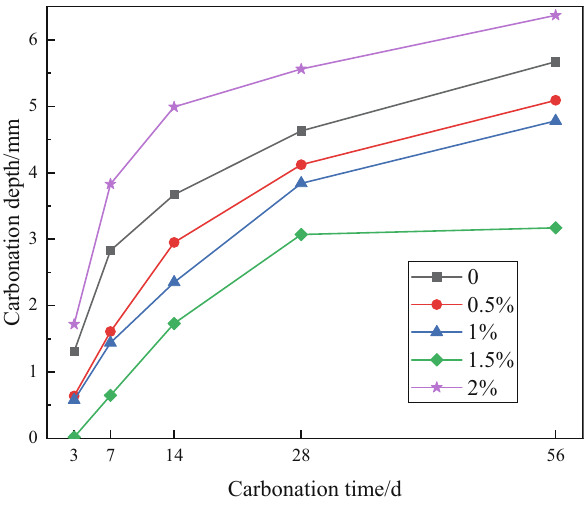
Figure 4: Carbonation depth curve of concrete with di ff erent steel fi ber contents [ 24 ] .